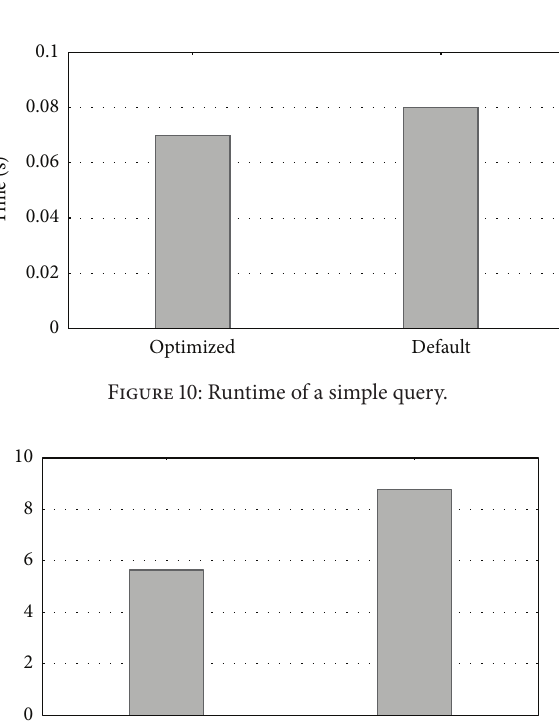
Figure 11: Runtime querying the Homo sapiens